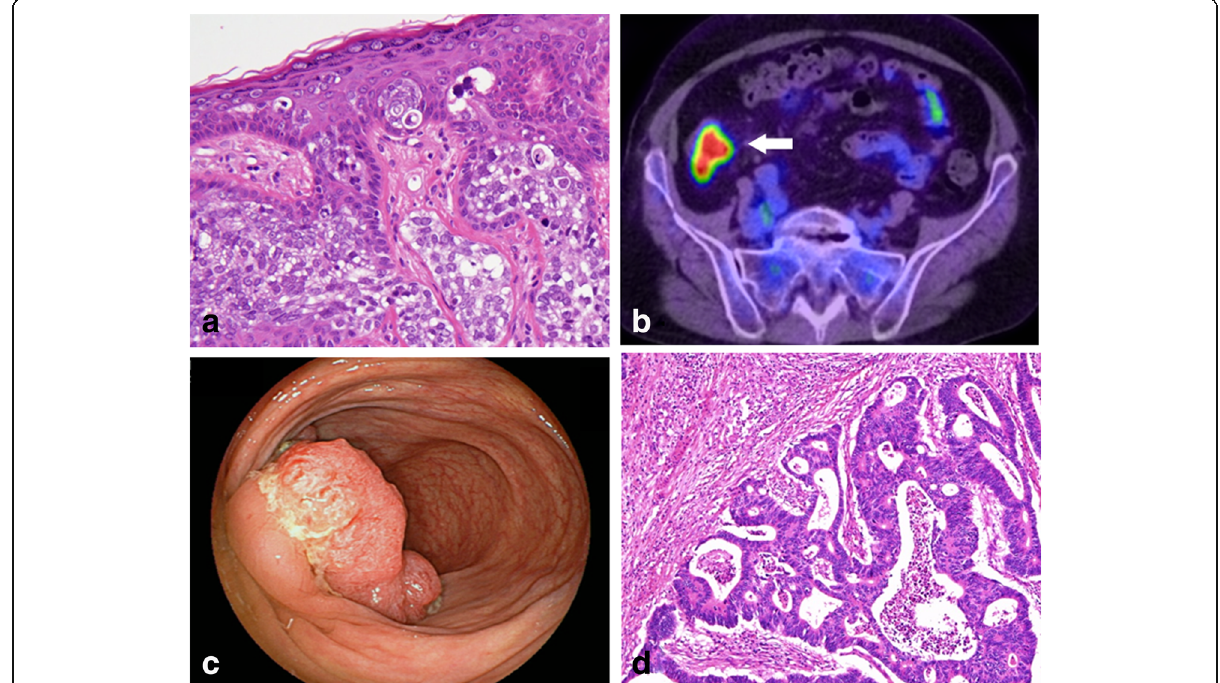
Fig. 1 Clinicopathological findings of case 1. a Pathological examination of a 5-mm-diameter skin tumor on the left upper eyelid revealed sebaceous carcinoma (hematoxylin and eosin stain (H.E.), ×200). b Positron emission tomography/computed tomography showed intense tracer uptake (maximum standardized uptake value=16.8) in the right lower abdomen ( white arrow ). c Colonoscopy showed a type 2 tumor in the ascending colon. d Pathological examination of the ascending colon tumor revealed heterogeneity of moderately and well-differentiated adenocarcinoma (H.E.,